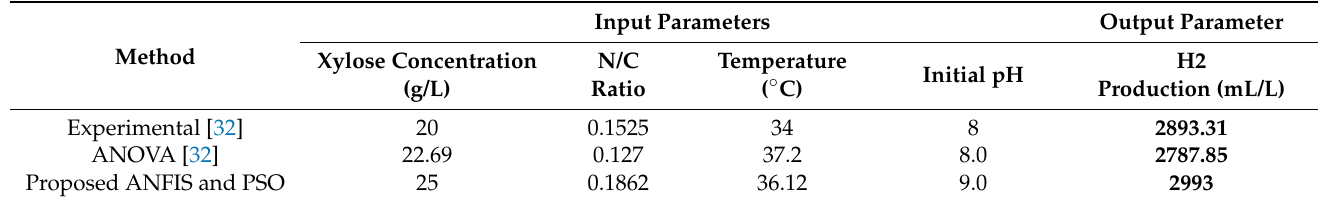
Table 1. Performance comparison between experimental, ANOVA, and proposed ANFIS–PSO